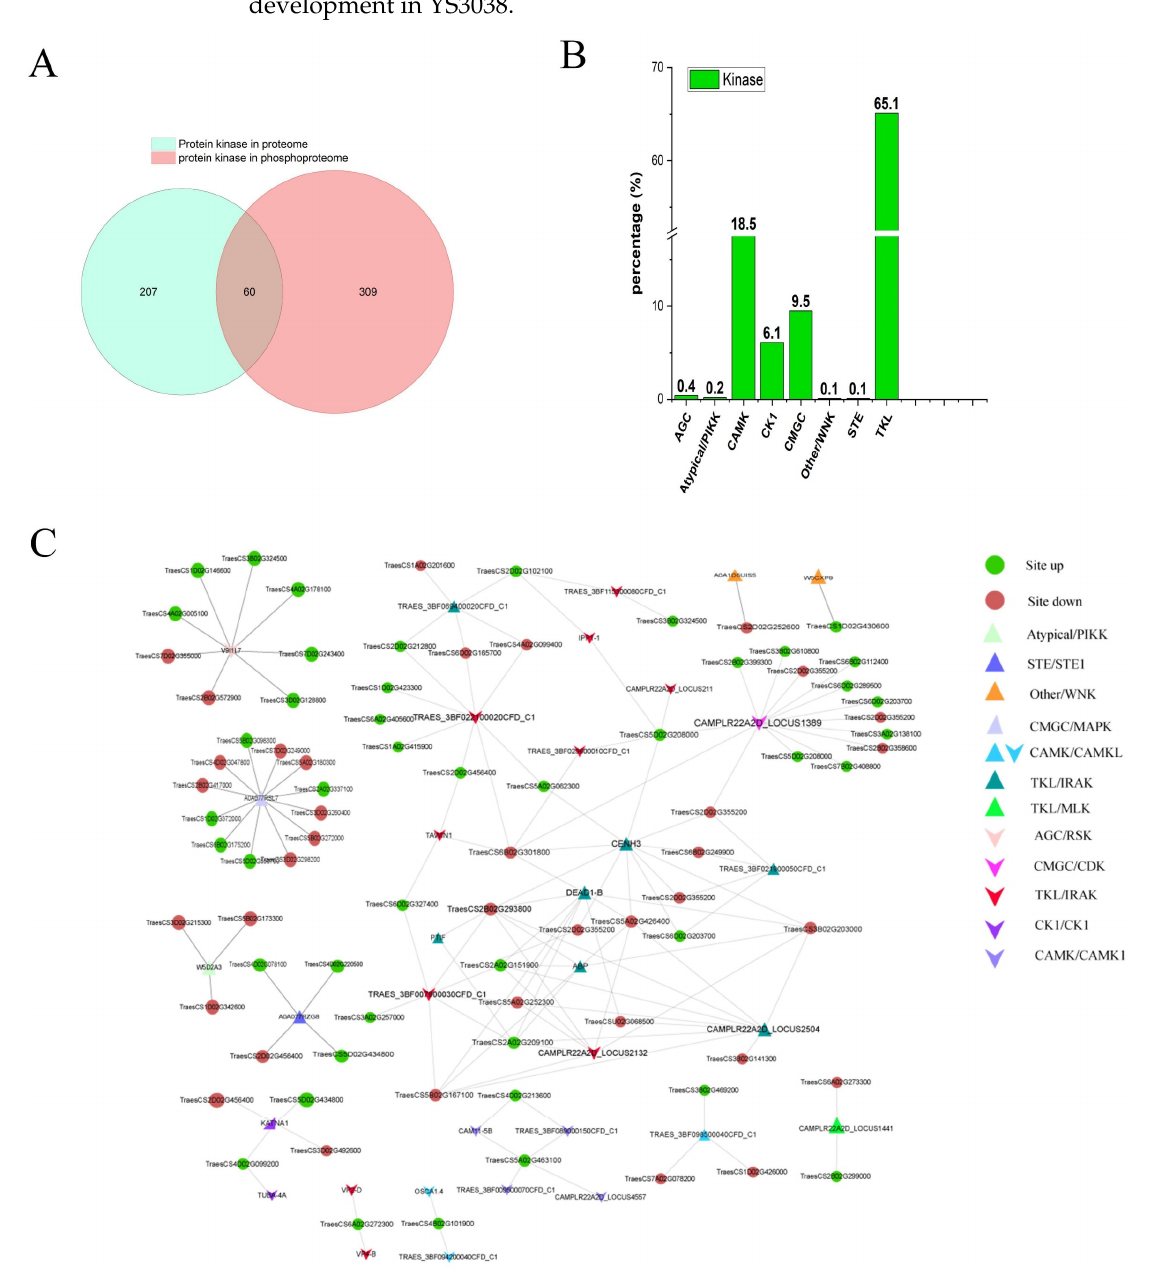
Figure 7. Overview of the kinases identified in phosphoproteome. ( A ) Overlap of the kinases identified in our datasets. ( B ) Significantly enriched kinase families in the phosphoproteome were identified. ( C ) The kinase–substrate network was extracted from the phosphoproteome data. Triangles represent up-regulated kinases, V-shapes represent down-regulated kinases, and circles represent substrates.